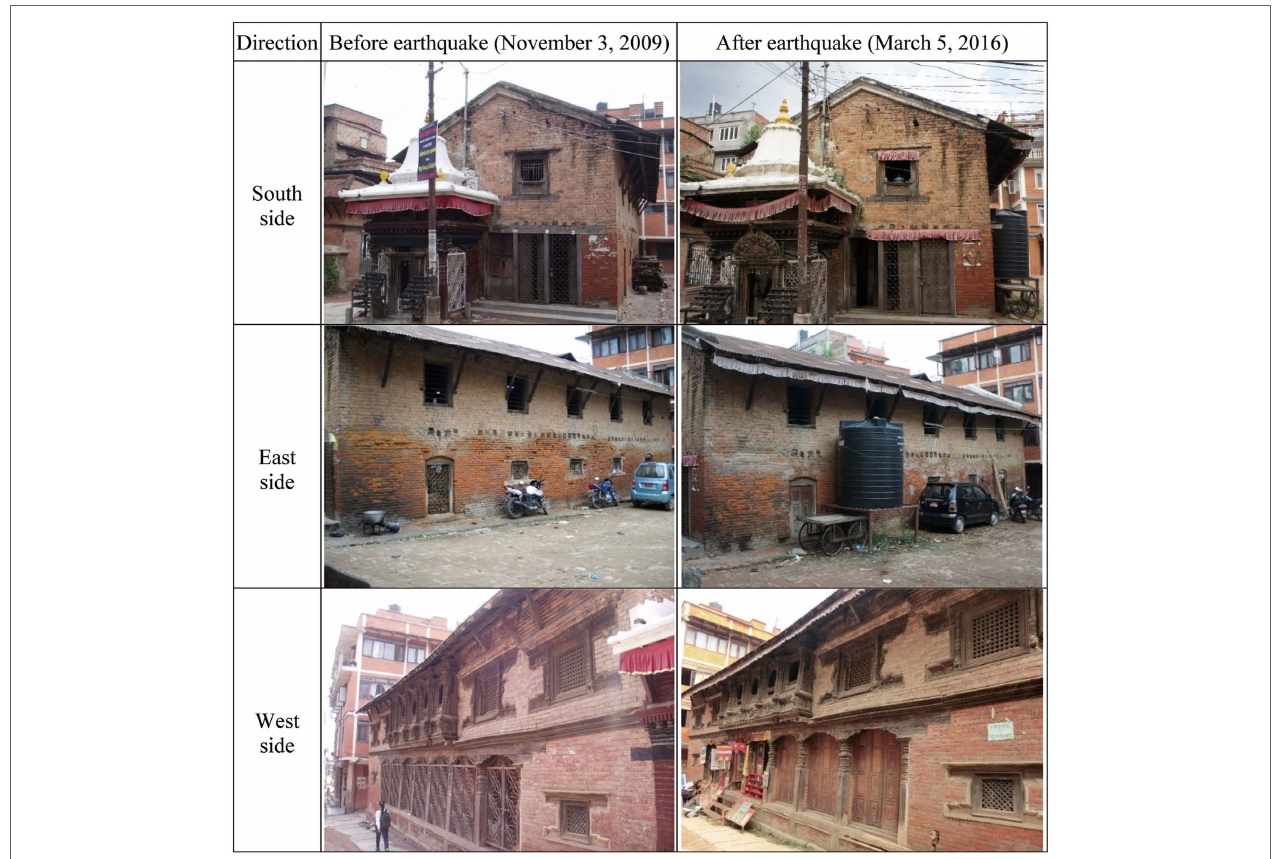
FIGURE 3 | Appearance of building before and after the 2015 Gorkha earthquake.